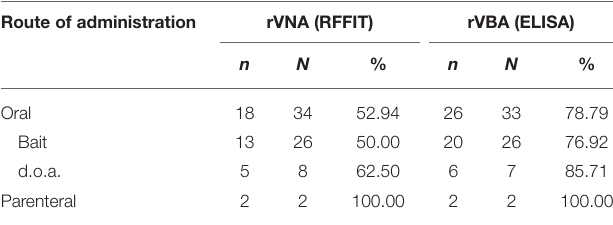
TABLE 1 | Seroconversion of local Namibian dogs after oral (bait and d.o.a.) and parenteral vaccination according to RFFIT ( > 0.5 IU/ml) and ELISA ( > 40% PB). Route of